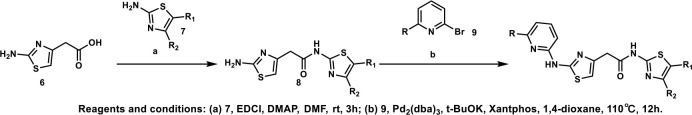
General procedure B.